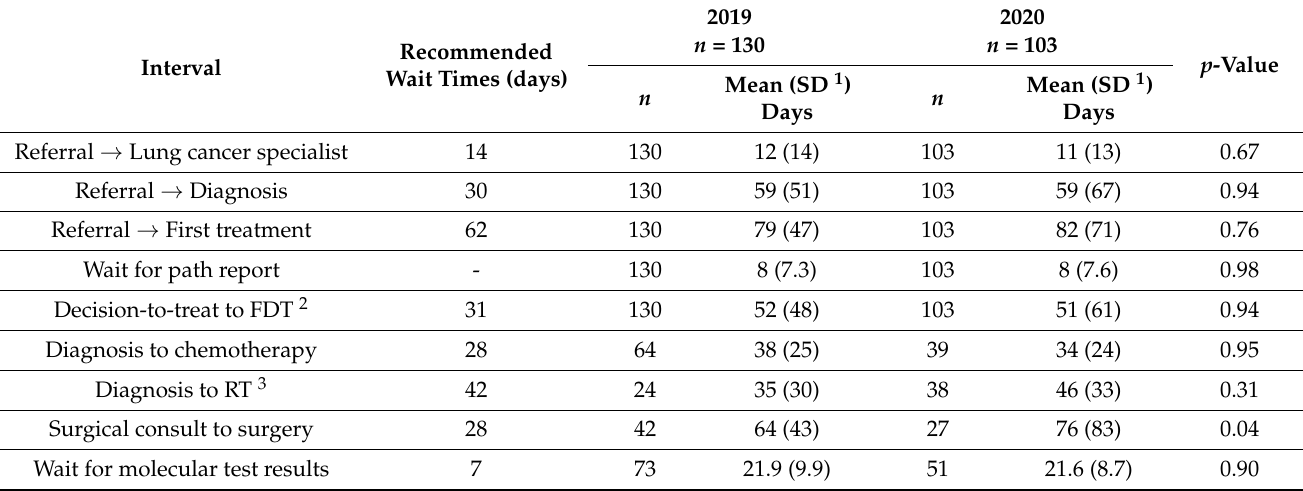
Table 4. Mean wait times before (2019) and during COVID-19 era (2020).